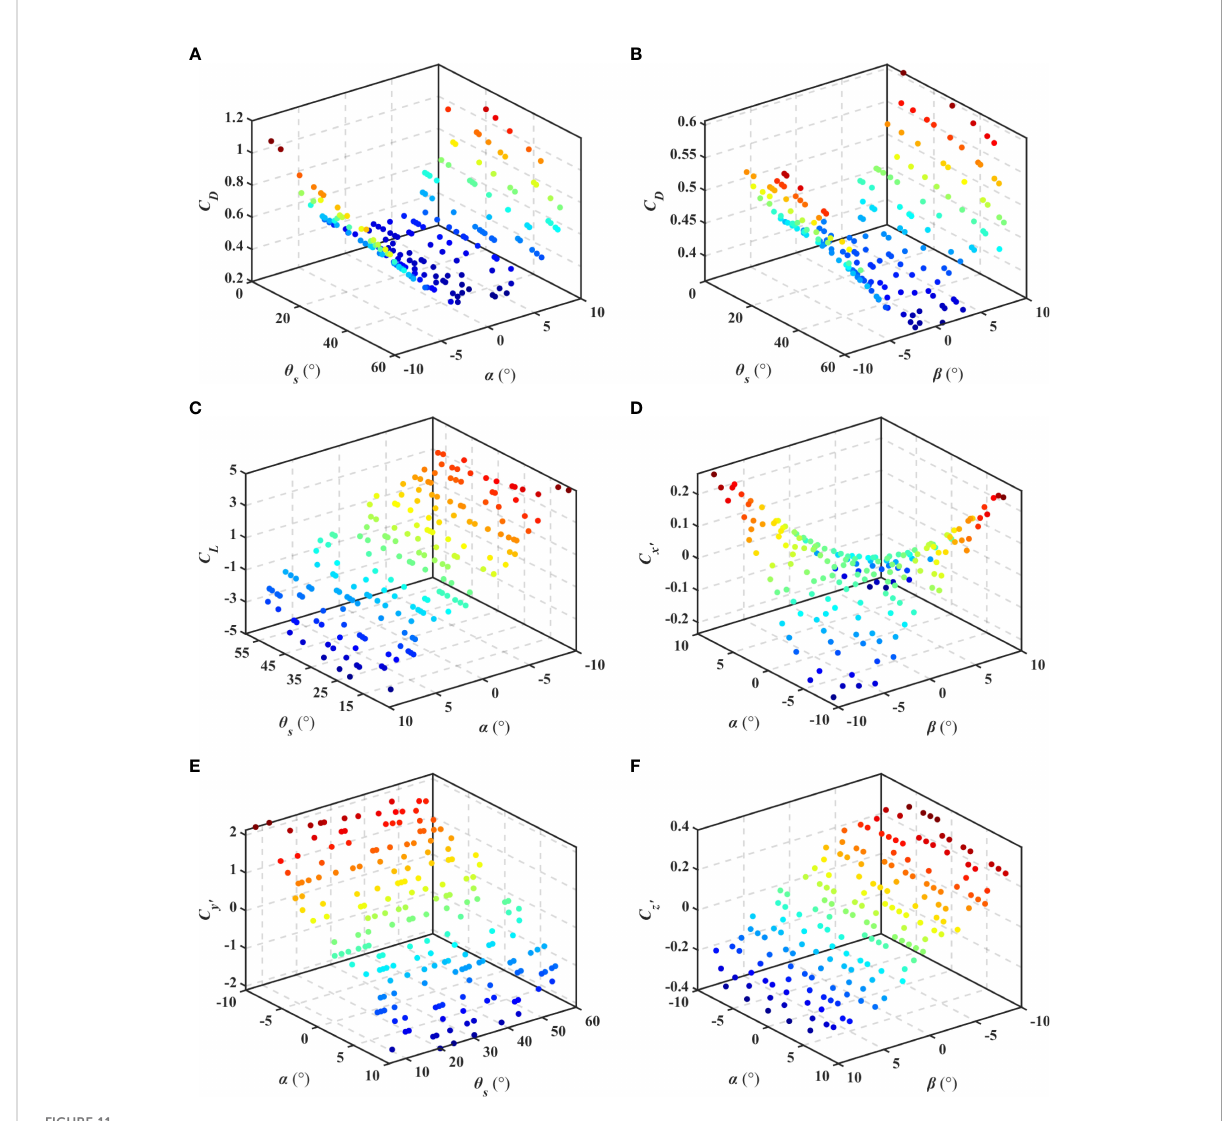
FIGURE 11 Hydrodynamic coef fi cients obtained in fl ume numerical